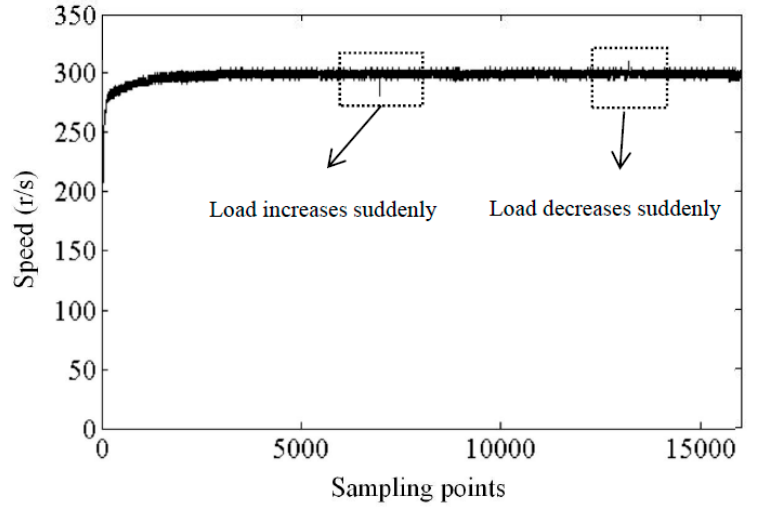
Figure 12. The experimental speed response with load changed suddenly using the proposed MFiPISTSMC strategy.